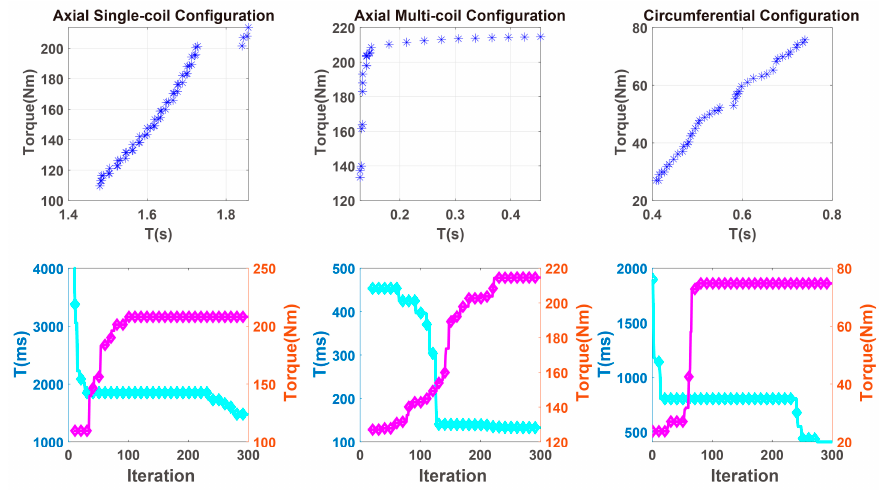
Figure 17. The optimized iteration results of the response time and damping torque of MR-TVA.